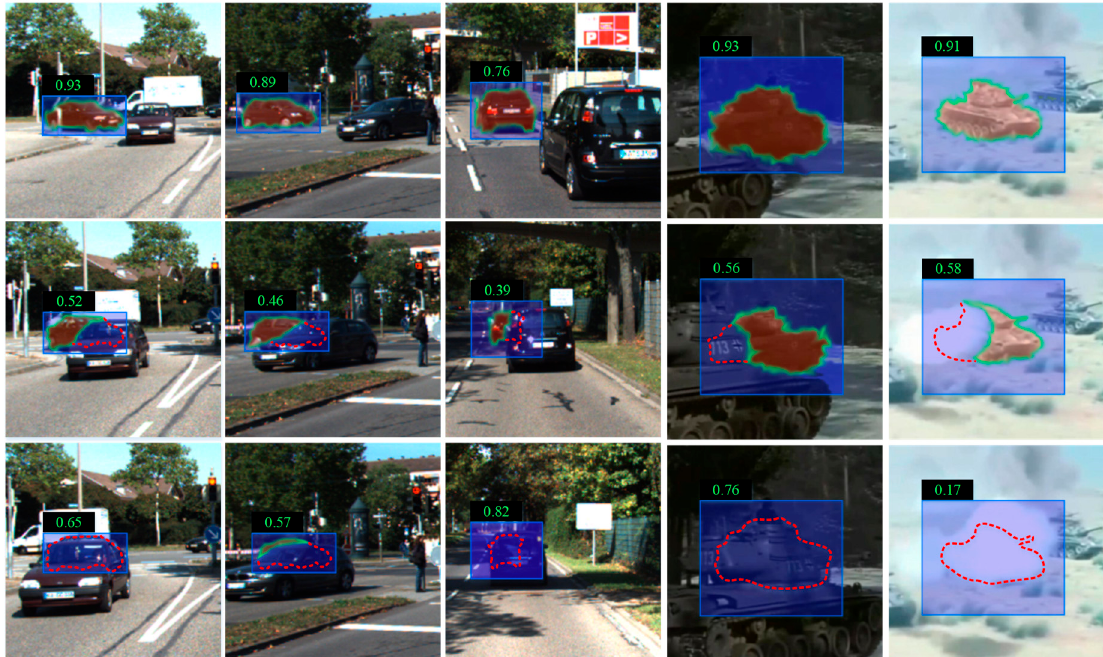
Figure 6. Examples of occlusion and generated visibility maps. The dotted lines surround the occluded targets. The blue bounding box is the predicted state set in the Motion Model. The numerical value is the classification score of candidates in the offline trained classifier.